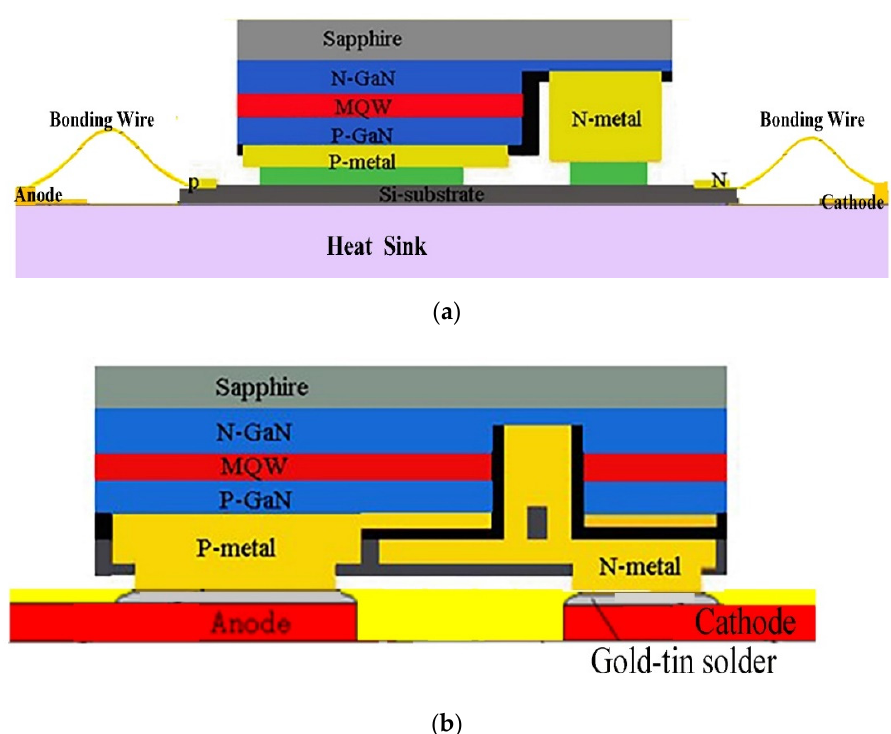
Figure 3. Schematic diagram of wired flip chip package structure ( a ) and wireless flip chip package structure ( b ).